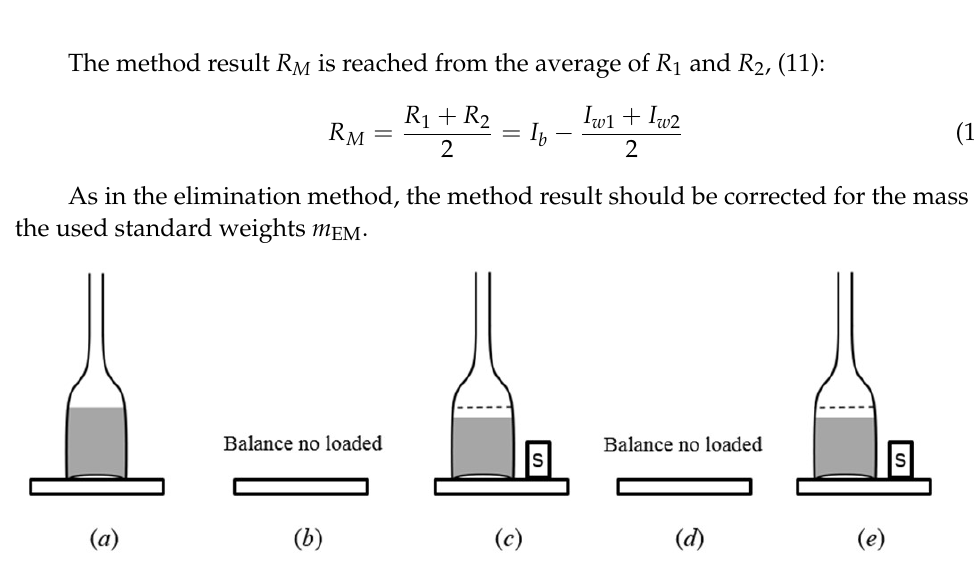
errors are considered null, but their uncertainty should be taken into account. Further, as